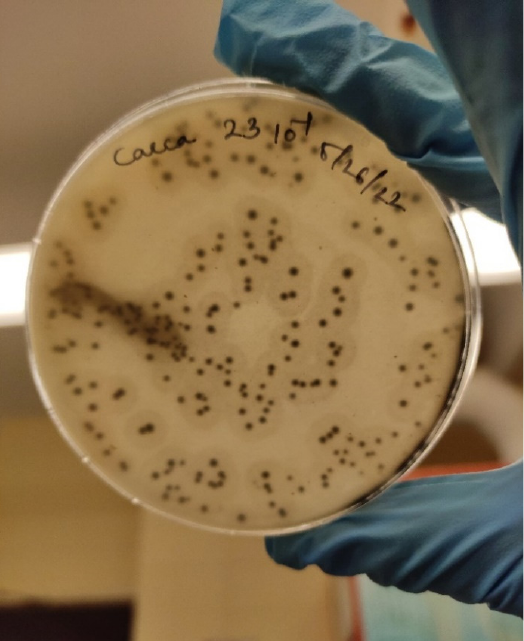
Figure 2. Growth of C. perfringens colonies on TSC agar supplemented with egg yolk emulsion. Table 3. Biochemical characteristics of C. perfringens .